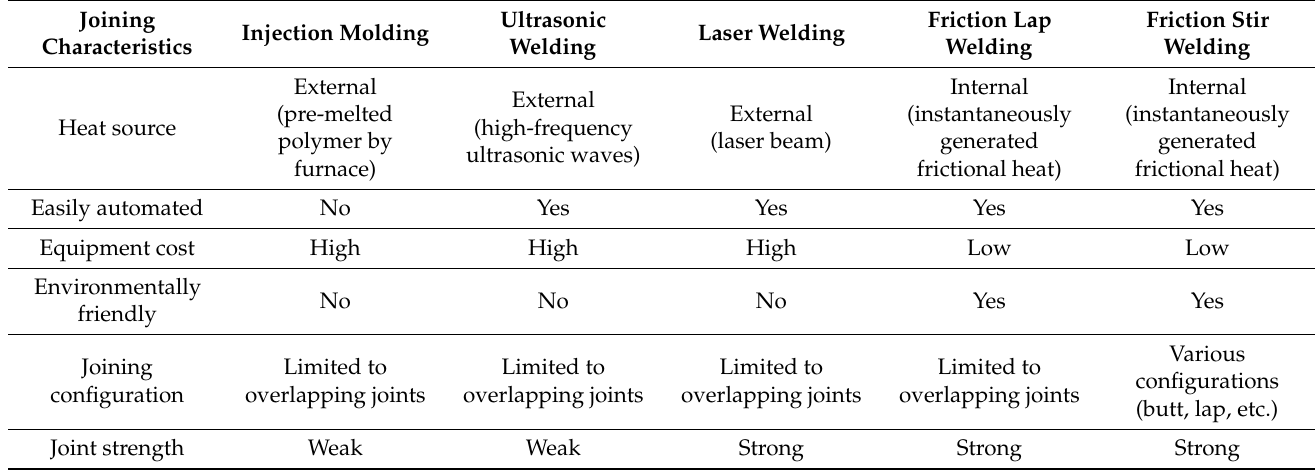
Table 2. Process characteristics for metal–polymer welding